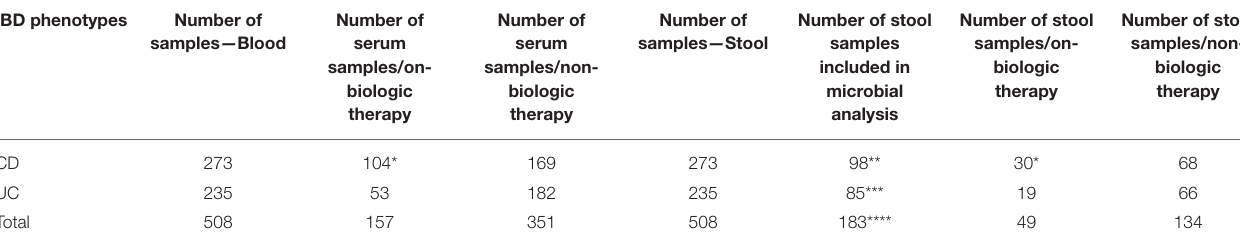
TABLE 2 | Sample distribution in IBD